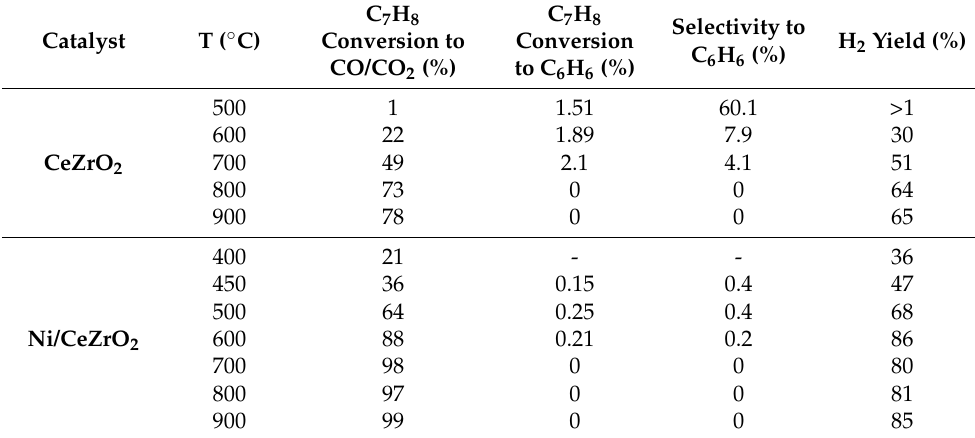
Table 1. The results of the catalytic runs of toluene steam reforming carried out in isothermal conditions on CeZrO 2 and Ni/CeZrO 2 catalysts (S/C = 2.4, t c = 0.36 s, TOS at each temperature was 4